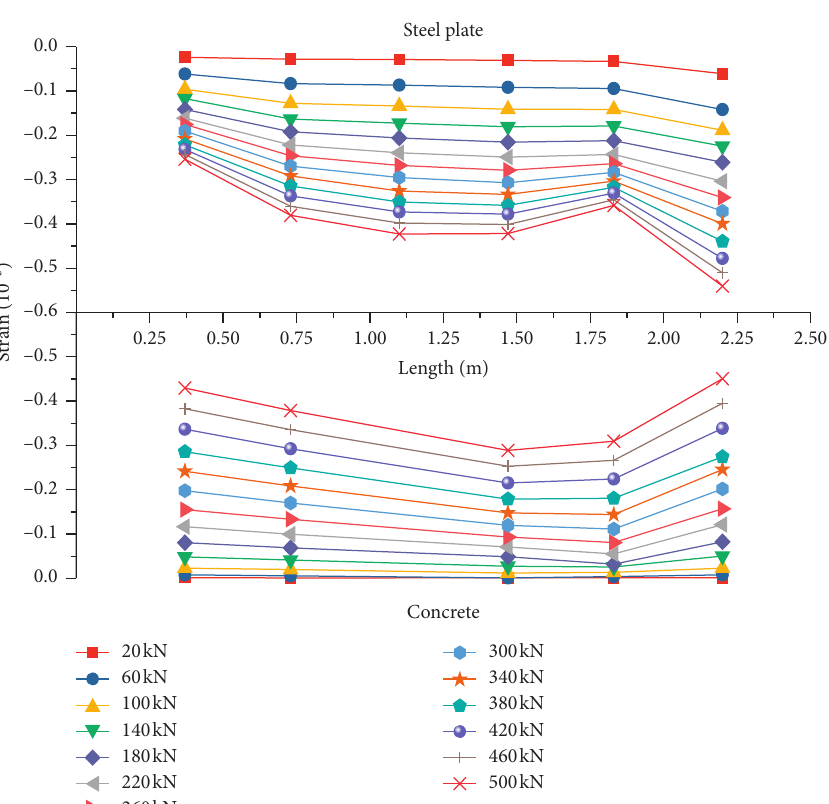
Figure 28: Strain distribution of SC-N1 in compressive